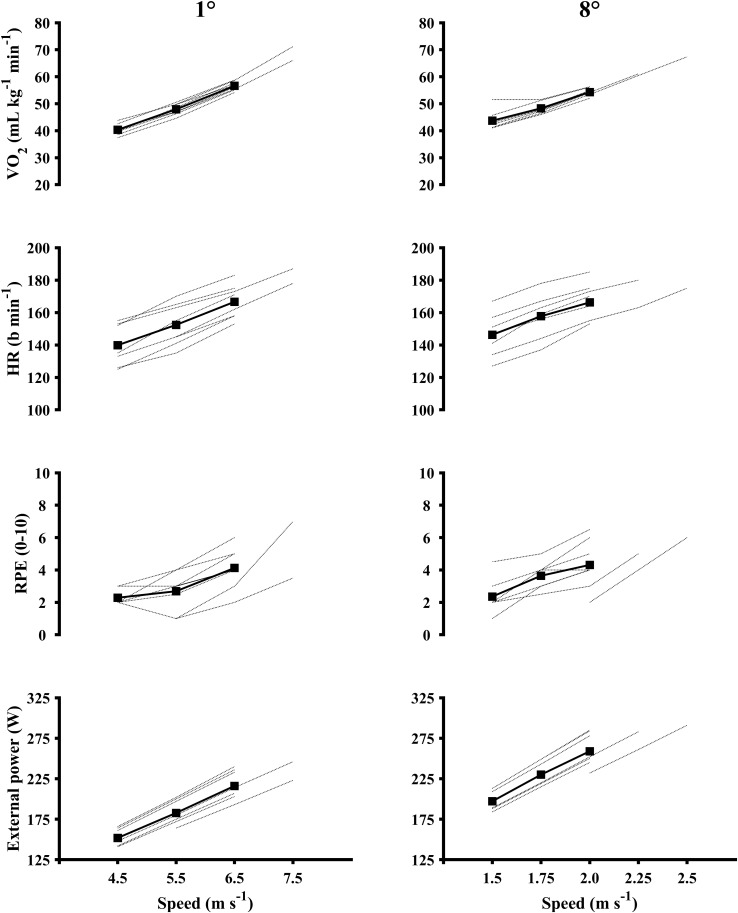
VO2, HR, RPE and external power during the submaximal level and inclined workloads on the roller ski treadmill. Square and solid line: average data. Dotted lines: individual data. (n = 8). Subject 2 completed one extra workload at 7.5 m⋅s-1 (total number of level workloads: 4) and one extra workload at 2.25 m⋅s-1 (total number of inclined workloads: 4). Subject 8 started the level submaximal workloads at 5.5 m⋅s-1 and the inclined submaximal workloads at 2.0 m⋅s-1.